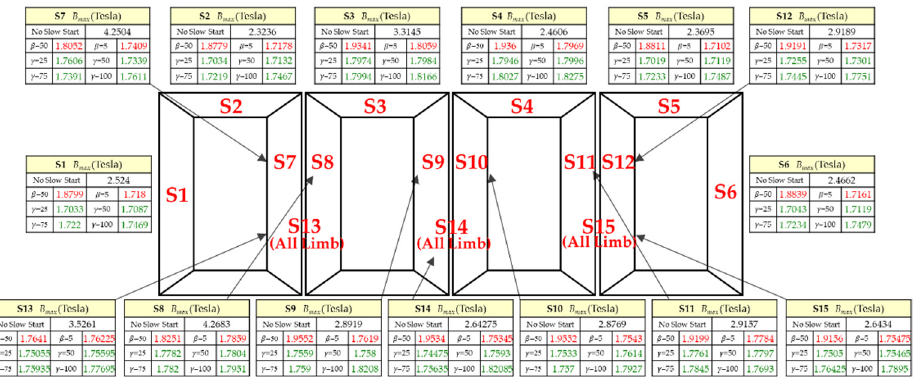
Figure 14. The simulation results of the magnetic flux density distribution under different external excitation functions.